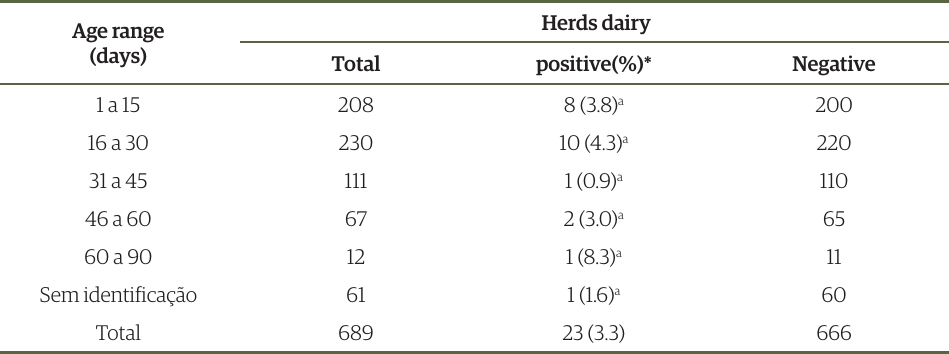
Table 3. Positive results in rotavirus PAGE according to the age range of calves in dairy cattle herds in the north of the State of São Paulo, from 2006 to